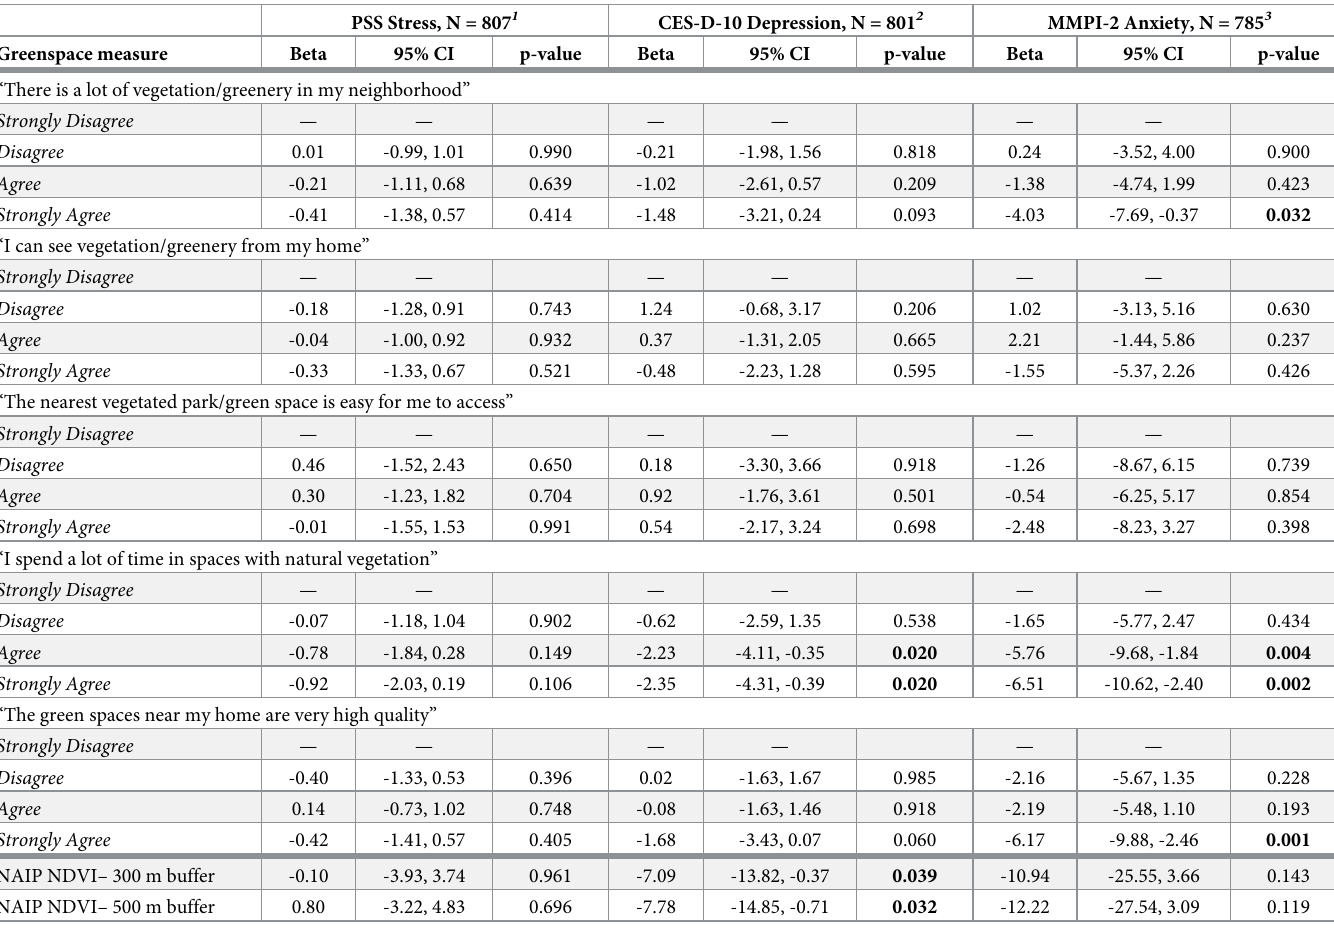
Table 4. Multivariate regression of measures of psychological stress and distress and perceived and objective green space, controlling for sociodemographic and COVID-19